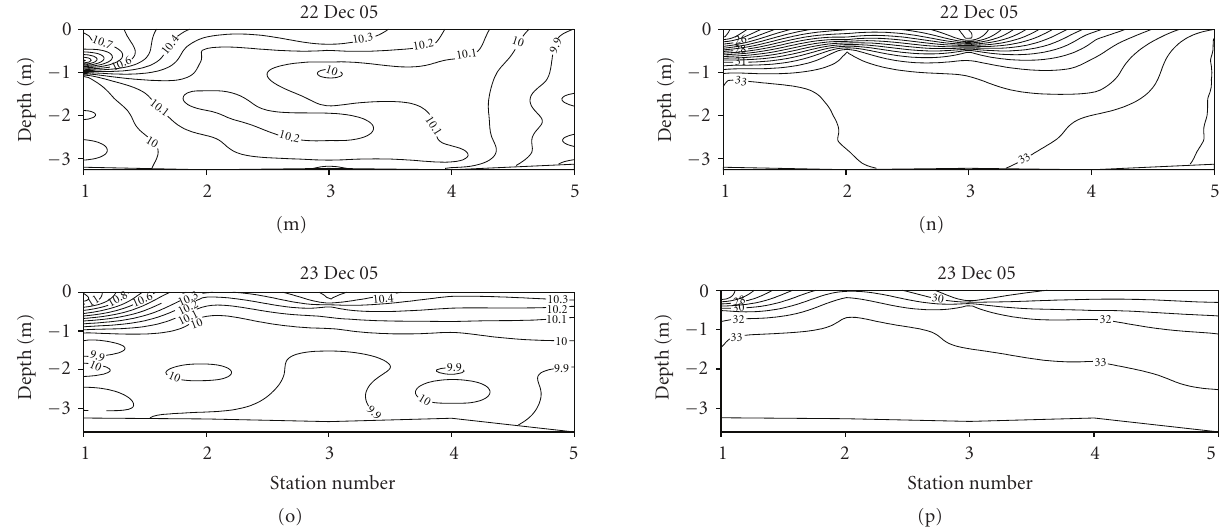
Figure 5: Snapshots at daily intervals of the two-dimensional distribution along the channel of salinity and SSC at Ngermeduu from CTD casts. The bottom line indicates the sea